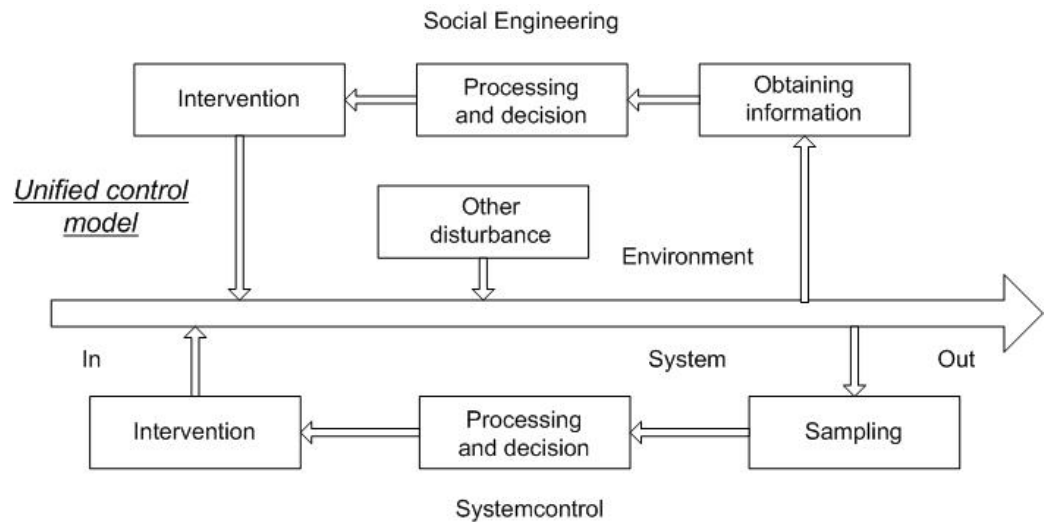
Figure 3. Unified model of cybernetic loop and social engineering.